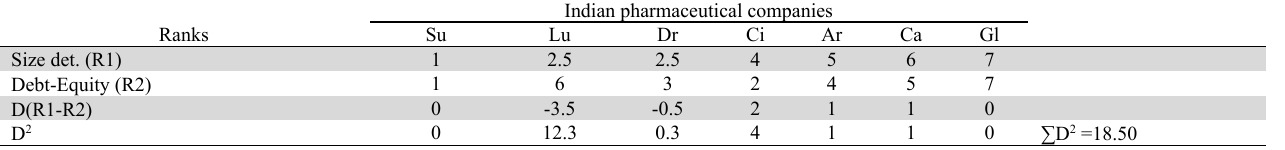
Originating Source: R1 and R2 from Table 1 and Table 4.